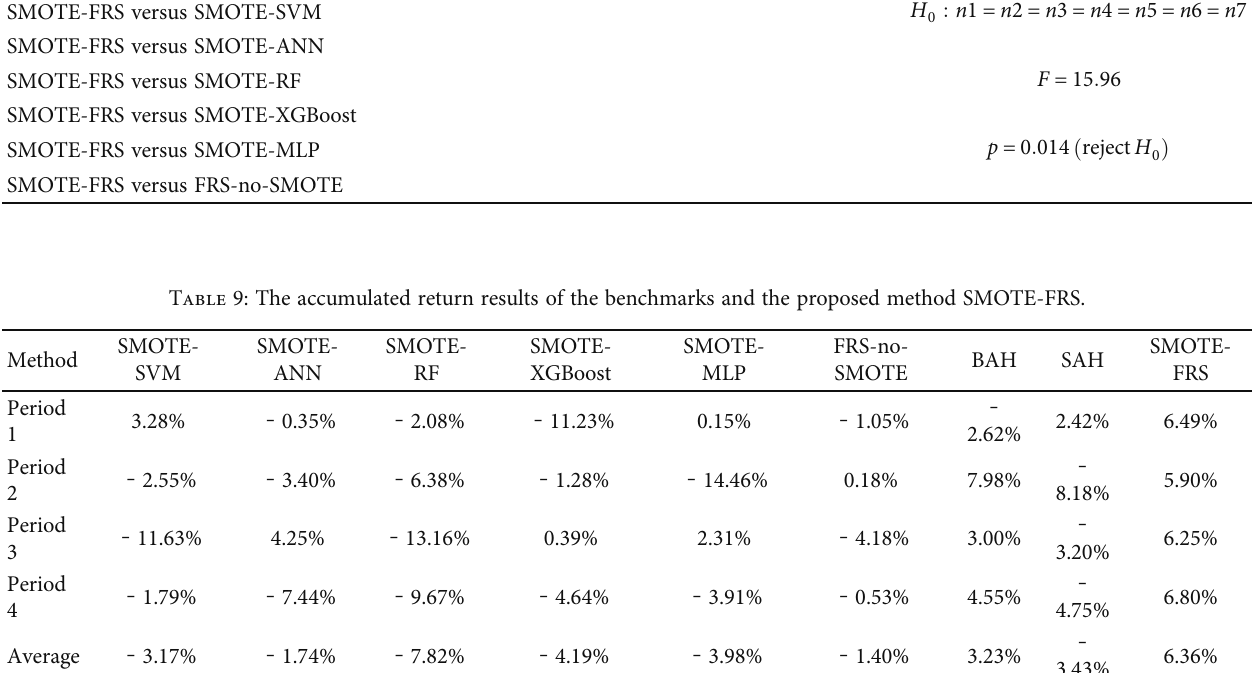
Table 8: Friedman test on the hit ratio results for the proposed method SMOTE-FRS against the benchmark methods. Compared models